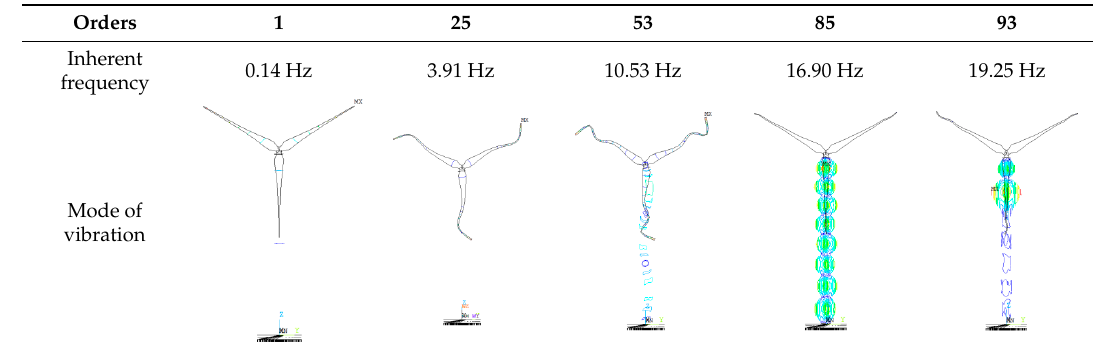
Table 3. Typical modes of vibrations of the wind turbine.